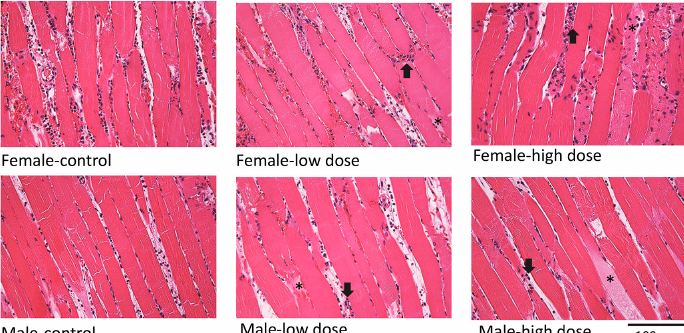
Figure 2. Effects of EV treatment on muscle morphology after I/R injury. Sections stained with hematoxylin and eosin show muscle fiber damage (asterisks) and cellular infiltration (arrows) with both low and high-dose treatment in male and female mice.